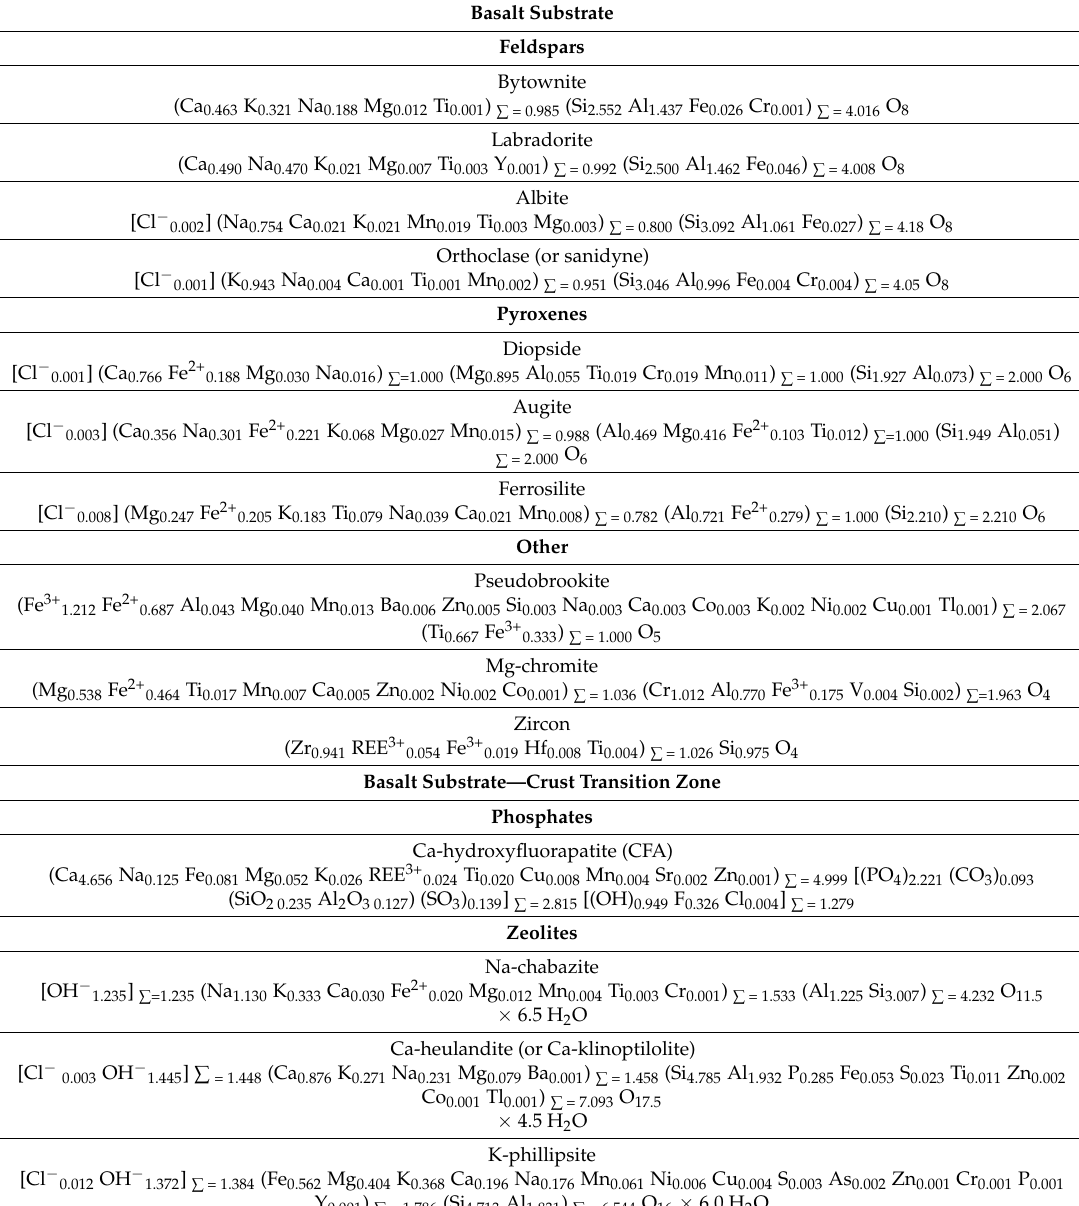
Table A2. The mean calculated empirical formulas of DHR Co-rich crusts minerals (basing on the EPMA